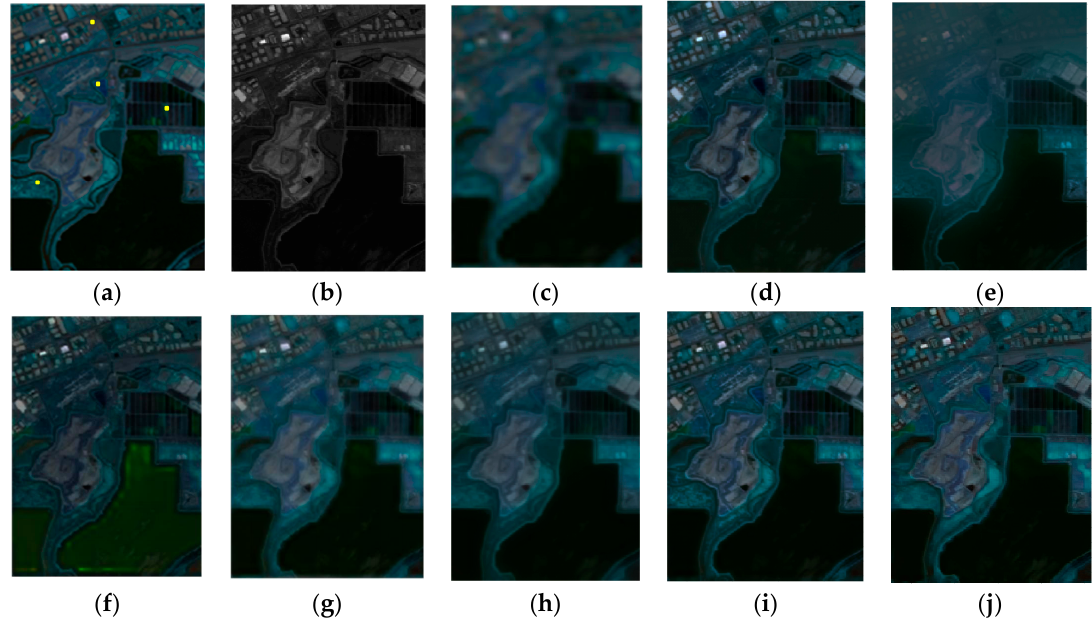
Figure 7. Fusion results obtained by each method for Moffett field dataset. ( a ) Reference HS image; ( b ) Simulated PAN image; ( c ) Interpolated HS image; ( d ) PCA; ( e ) GFPCA; ( f ) BT; ( g ) CNMF; ( h ) BSF; ( i ) MGH; ( j ) STF. Table 3. Quantitative results of different fusion methods for Moffett field dataset.